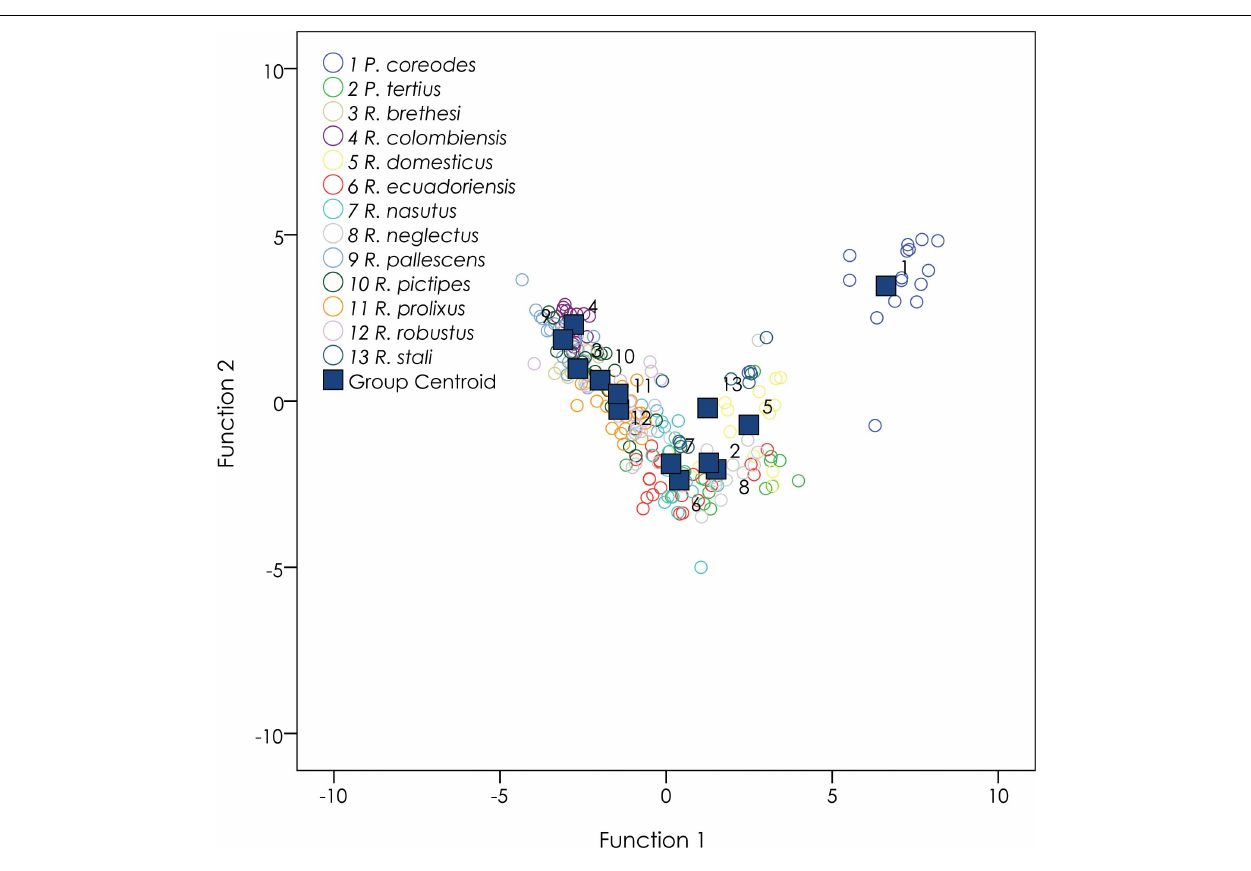
FIGURE 7 | Linear discriminant functional analysis for Rhodniini. All species were significantly different in the results of pairwise F-ratios for testing group differences (see Supplementary Table 7 ). 75.4% of original grouped cases were correctly classified. 66.5% of cross-validated grouped cases were correctly